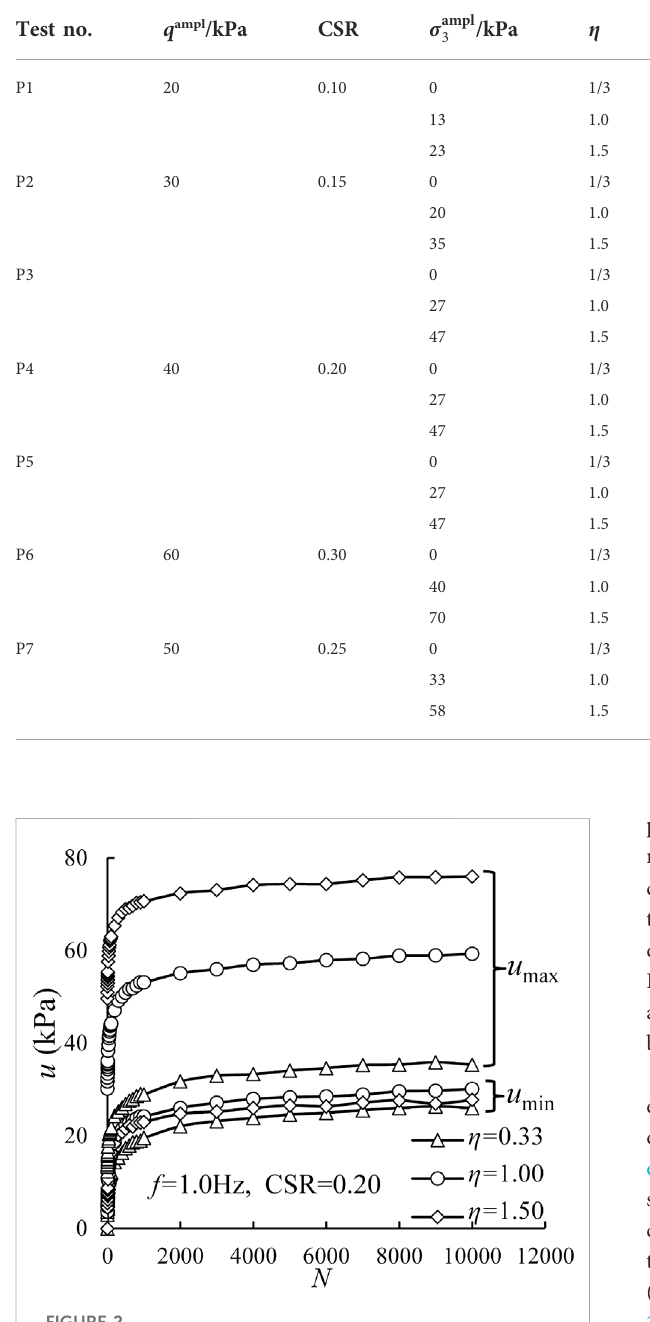
FIGURE 2 Variations of excess pore water pressure with number of cycles under different η for CSR = 0.20 and f = 1.0